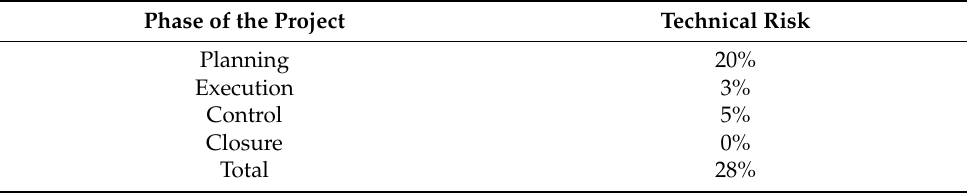
Table 6. Technical risk assessment at different phases of CHP